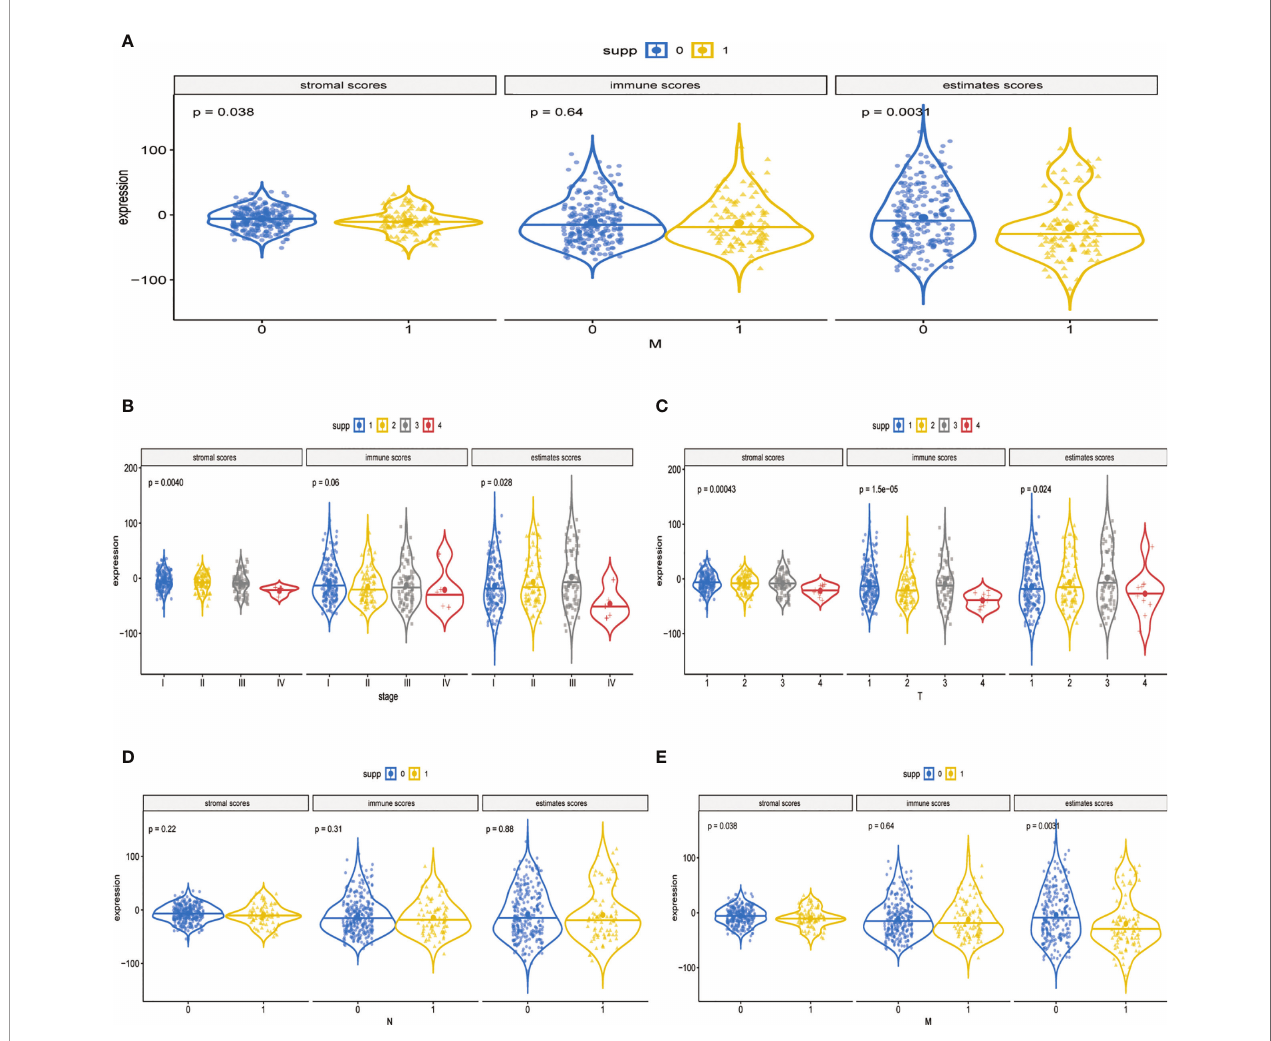
FIGURE 6 | Validation of immune estimate in the MAPK-RAP1A dataset. (A) The corresponding stromal score, immune score, and estimated score of MAPK- RAP1A gene signature between low-immunity group and high-immunity group. (B) Scores of stromal, immune, and ESTIMATE in HCC samples with different TNM stages. (C) Scores of stromal, immune, and ESTIMATE in HCC samples with different T stages. (D) Scores of stromal, immune, and ESTIMATE in HCC samples with different N stages. (E) Scores of stromal, immune, and ESTIMATE in HCC samples with different